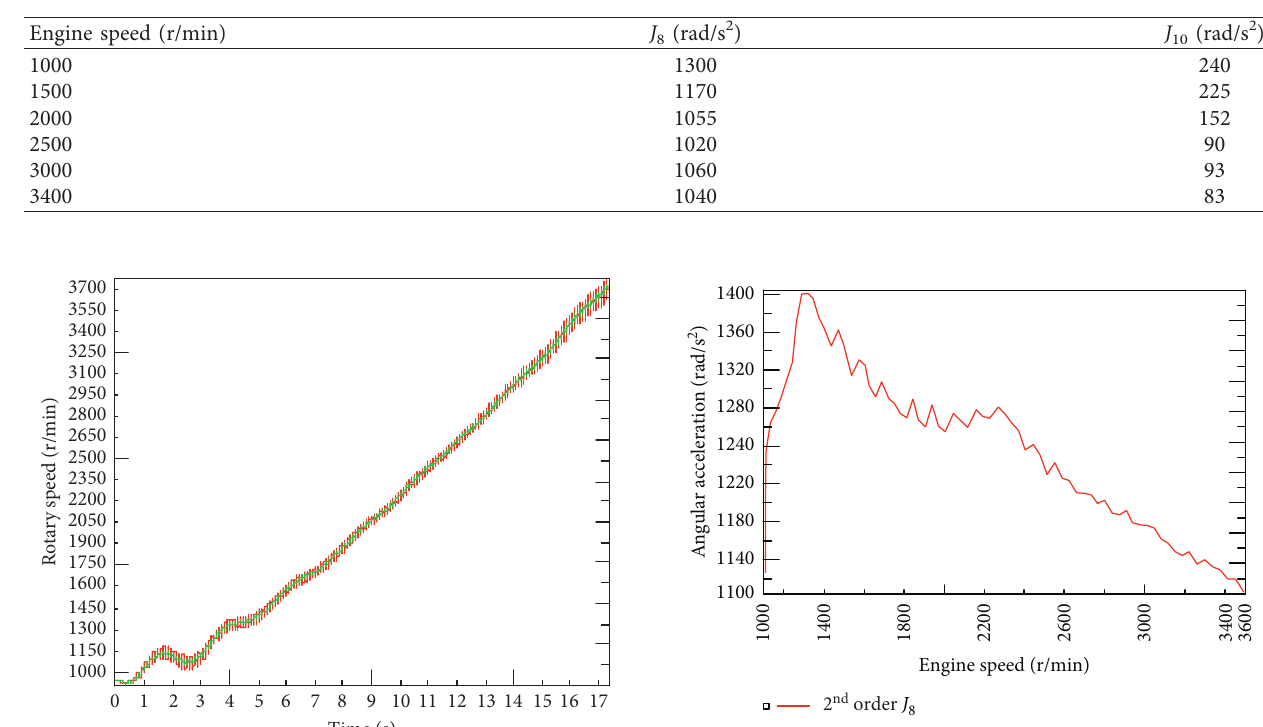
Figure 38: The 2 nd order angular acceleration curve of the primary flywheel matching without the CPVA under driving